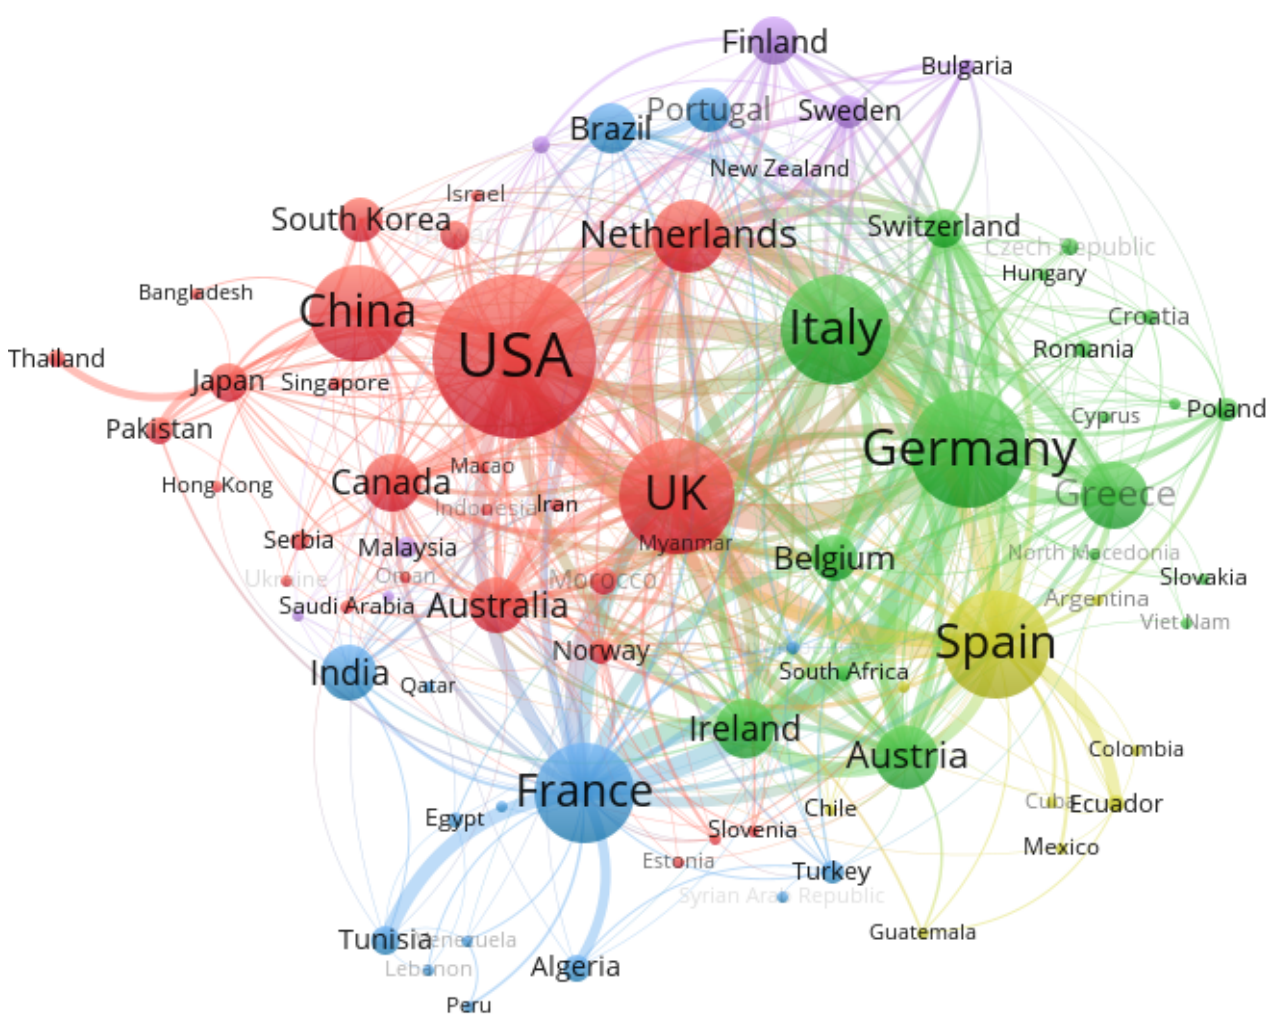
Figure 2. Network of international collaboration for interoperability and semantic web research.